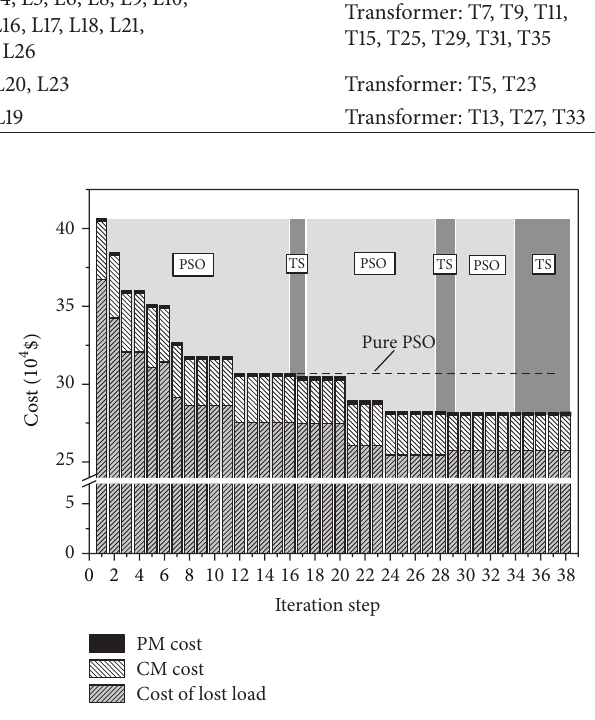
Figure 5: Composition of the total cost in the iteration